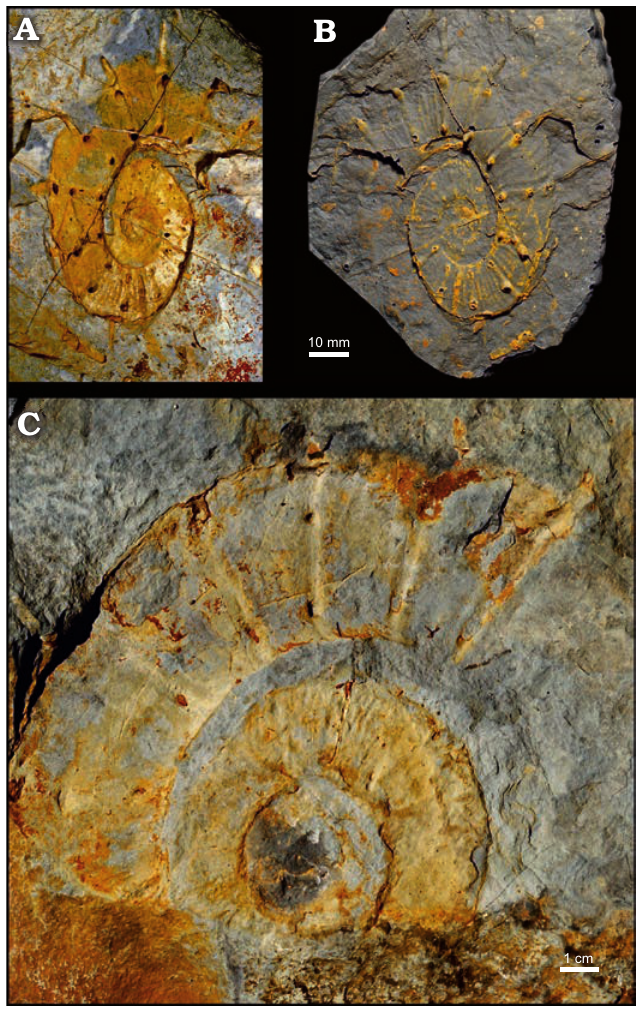
Fig. 5. The Lower Cretaceous heteromorph ammonite Crioceratites coni­ ferus Busnardo, Charollais, Weidmann, and Clavel, 2003 from the Koś­ cie liska Marl Formation in the Lejowa Valley, Tatra Mountains, Poland. A . GEO.1.2018. B . ZPAL Am. 25/1 (silicone cast). C . G/1729/MT. All in lateral